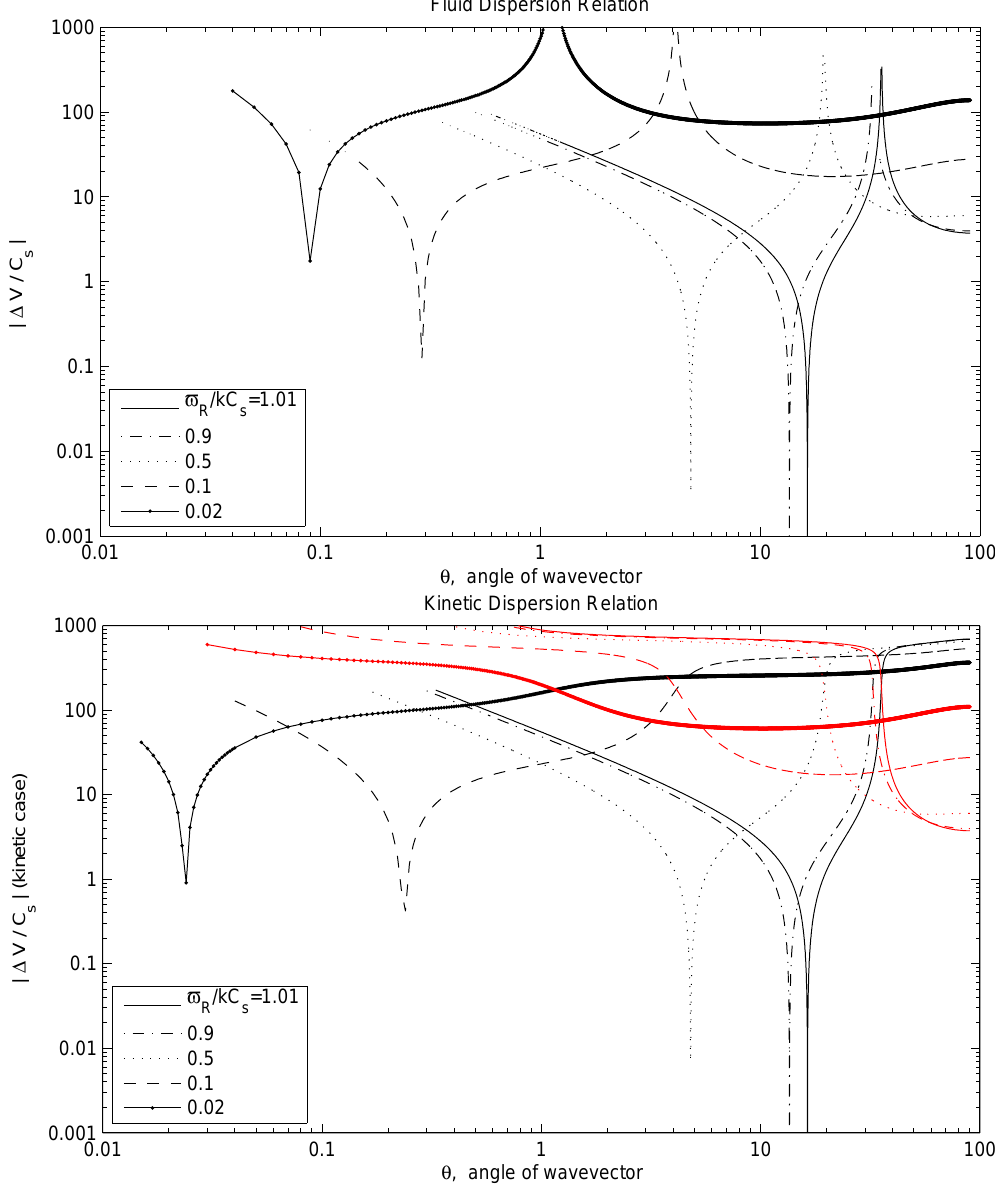
Fig. 2. Relative drift as a function of wavevector angle for the cases described in Fig. 1. The angle is 0 ◦ when the angle is perpendicular to B and 90 ◦ when parallel to it. The line scheme is the same as in Fig.